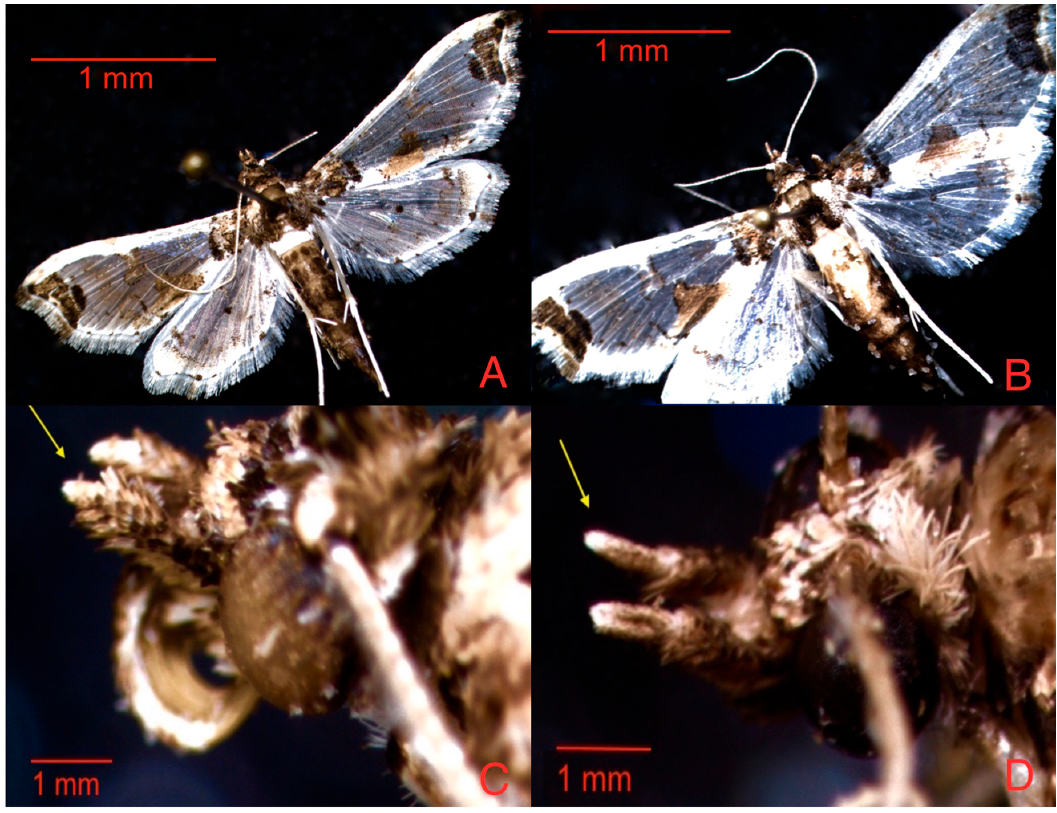
Figure 1. Adults of N. elegantalis ; ( A ) male; ( B ) female; ( C ) labial palpus of male adult; and ( D ) labial palpus of female adult.